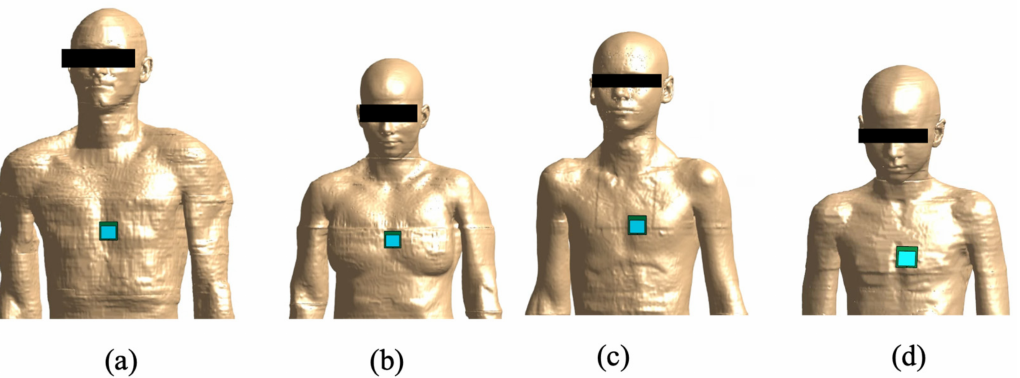
Figure 4. Overview of the simulated exposure configurations when the antenna tuned to 3.5 GHz is positioned on the model: ( a ) Duke, ( b ) Ella, ( c ) Louis, and ( d )